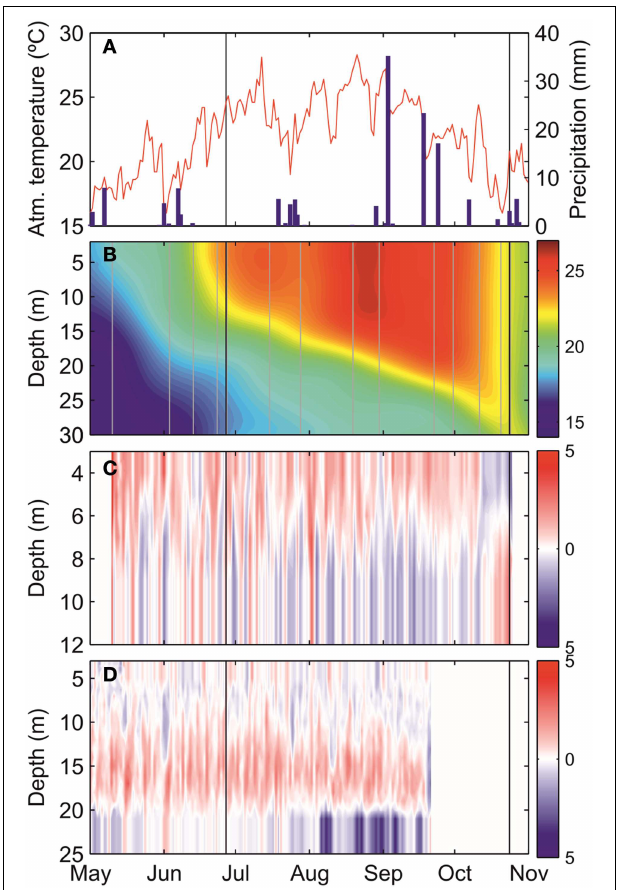
FIGURE 2 | Time-series of (A) atmospheric temperature ( ◦ C, red line) and daily accumulated precipitation (mm, blue bars), (B) seawater temperature ( ◦ C) at station 10, (C) alongshore current (cm s − 1 ) at the inner ADCP, and (D) alongshore current (cm s − 1 ) at the middle ADCP. Vertical black lines indicate the survey dates (June and October) and both black and gray lines in (B) are the measured temperature profiles in the monitoring program. Blue and red color in (C,D) represent inshore and offshore direction,